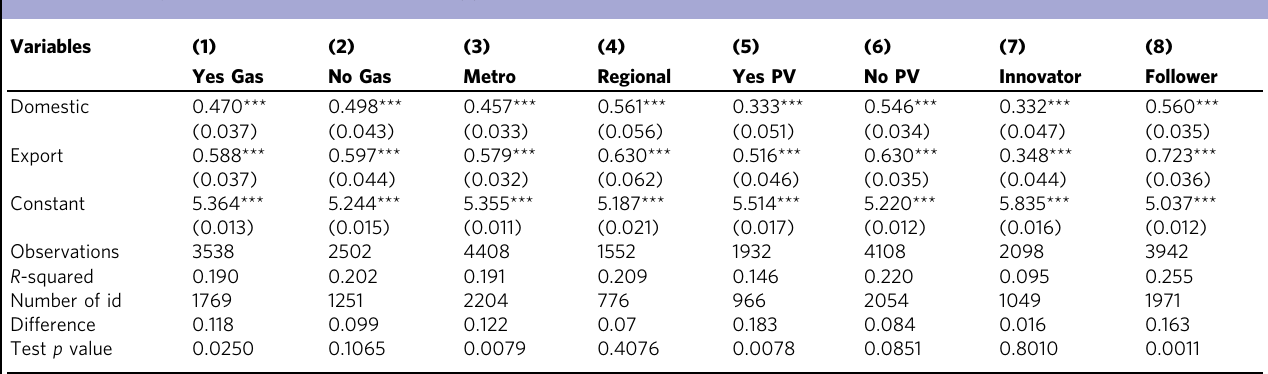
Table 3 Heterogeneous effect of the SV on